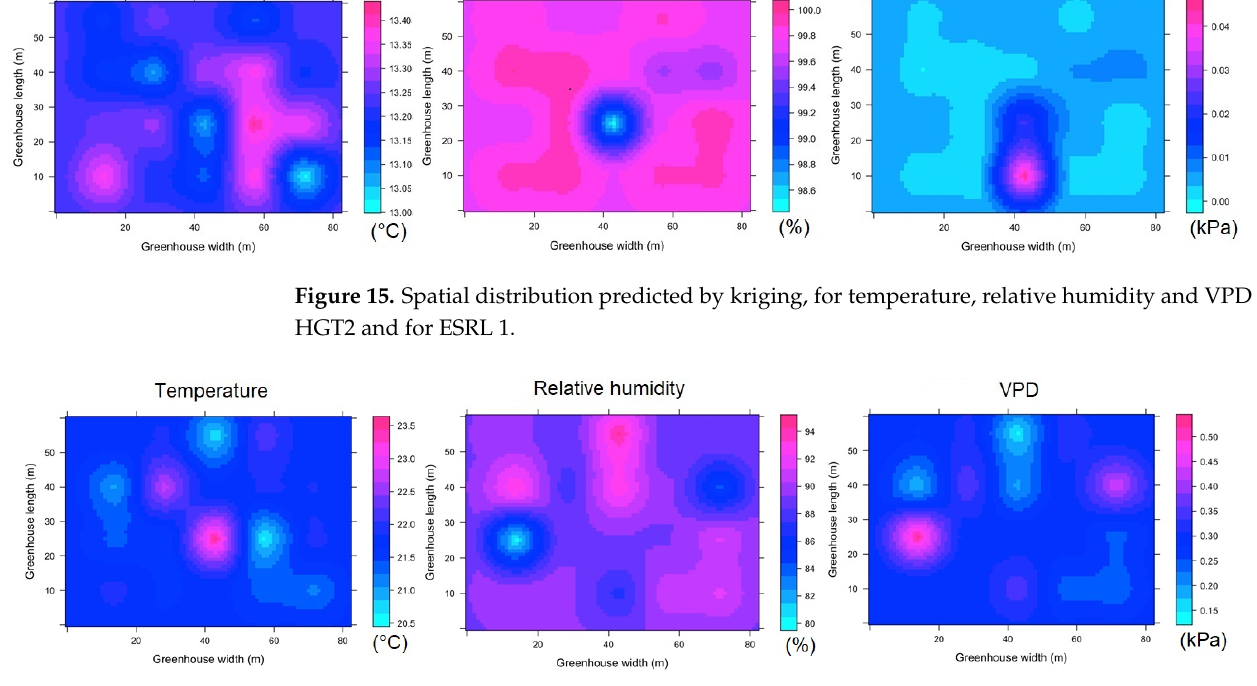
Figure 16. Spatial distribution predicted by kriging, for temperature, relative humidity and VPD in HGT2 and for ESRL 5.